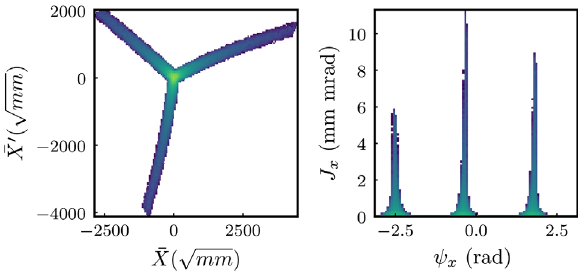
FIG. 3. Simulated normalized horizontal phase space (left) and action-angle variable representation (right) at the electrostatic septum in the SPS about 150 turns after the start of the spill.